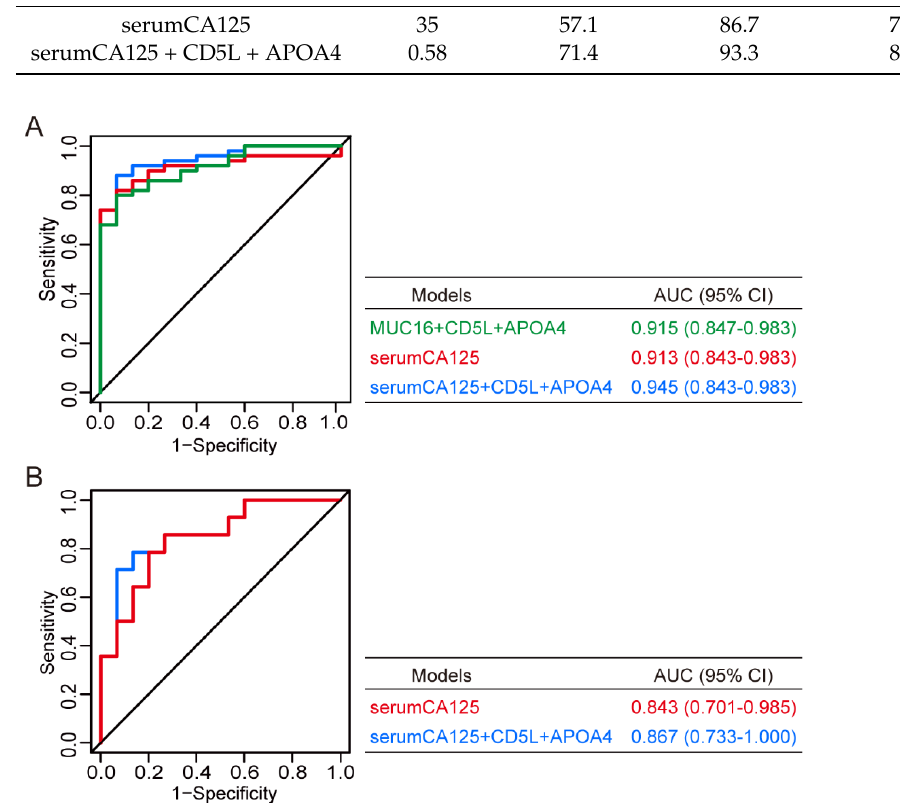
Figure 7. Development of a novel model for differential diagnosis between ovarian cancer and ovarian cystadenoma. ( A ) ROC analyses of serumCA125, a panel comprising MUC16, CD5L, and APOA4 in sEVs, and a panel comprising serumCA125, CD5L, and APOA4 in sEVs. The protein biomarkers in sEVs and serum CA125, or their combination to establish a diagnostic model, analyze their performance in the differential diagnosis of cystadenoma and ovarian cancer. ( B ) Comparison of serumCA125 and the novel panel comprising serumCA125, CD5L, and APOA4 in sEVs for pa ‐ tients with early ‐ stage ovarian cancer. Table 7. The logistic regression model for differential diagnosis of ovarian masses. Multivariate Analysis Proteins